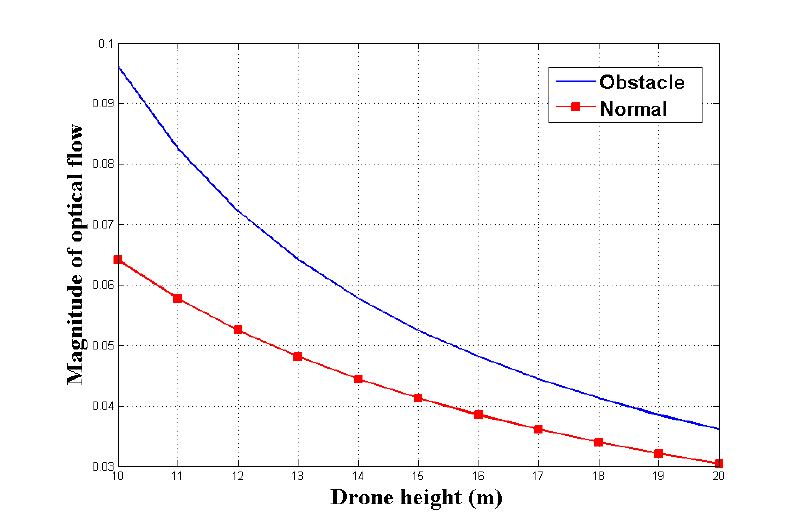
Figure 6. Magnitude of optical flow modeling.